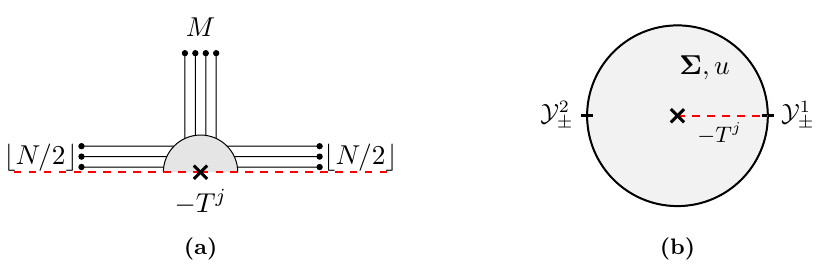
Figure 6. On the left the 5-brane junction for the ? (cid:6) theories; if N is odd there is an unpaired N;M;j D5 stuck on the orientifold, if M is odd there is a fractional NS5 on the orientifold. On the right the associated ? (cid:6) solution with two 5-brane poles and one puncture with (cid:0) T j monodromy, N;M;j with the branch cut intersecting the pole corresponding to D5